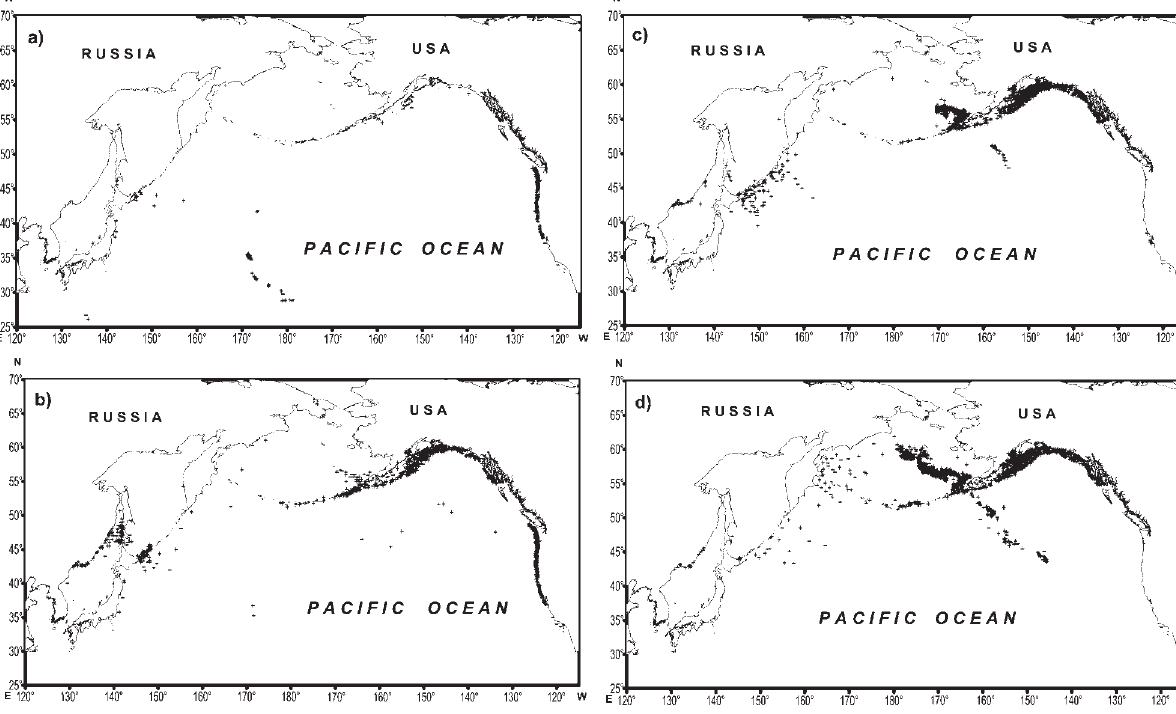
Fig . 4. – Capture sites of Squalus suckleyi in the North Pacific by decades, 1970-2008: in 1970-1980 (a), in 1981-1990 (b), in 1991-2000 (c), and in 2001-2008